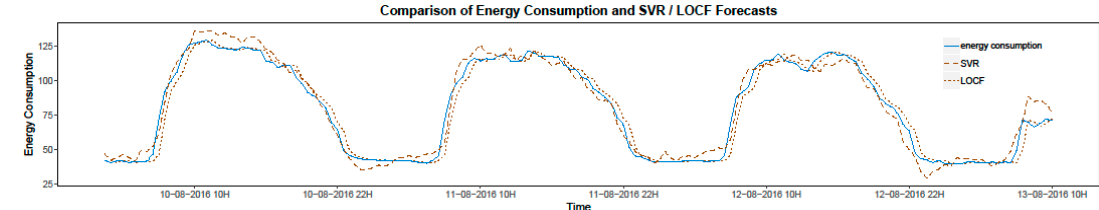
Figure 10. Comparison of LOCF forecasting, SVR forecasting, and measured data.